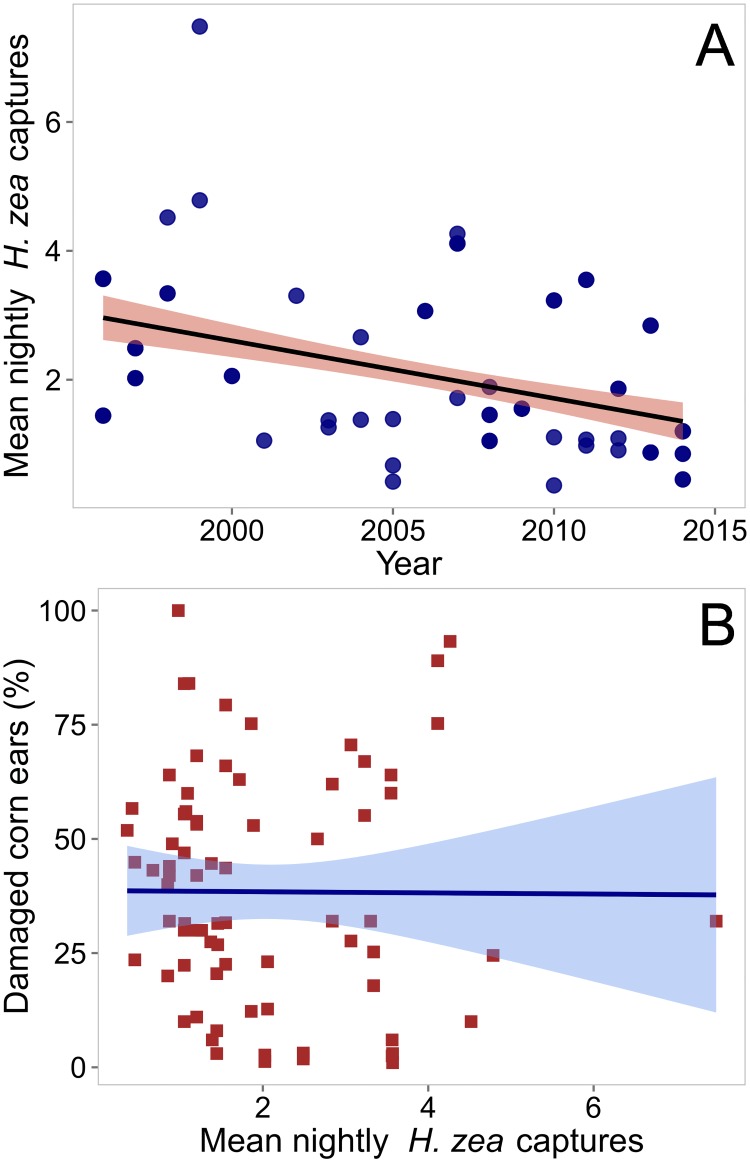
Mean nightly captures of Helicoverpa zea in black light traps during 1996–2014 in Maryland, USA and its association with damage to Bt corn hybrids.The population abundance of H. zea at or near study sites decreased over the past two decades (A), and showed no relationship with damage levels in Bt sweet corn hybrids (B). Lines represent predictions from LMMs and shades depict upper and lower confidence intervals (95% CI).